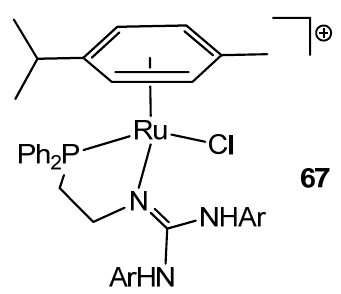
Figure 40. Phosphane-modified guanidine as ligand in a ruthenium complex.